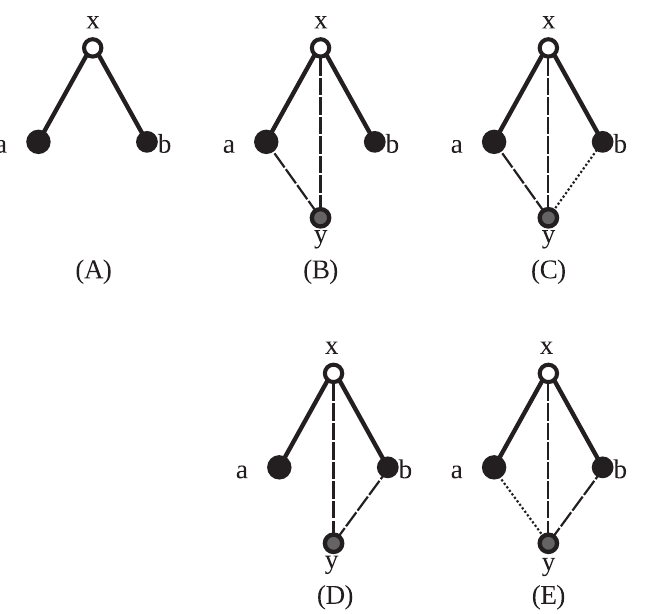
Fig 10. Construction of an equation. (A) G ( x ) ’ Orbit representative 2. (B) G 0 ( x ) = G ( x ) [ {{ y , x }, { y , a }} ’ Orbit representative 11. (C) G 0 ( x ) [ { y , b } ’ Orbit representative 13. (D) G 00 ( x ) = G ( x ) [ {{ y , x }, { y , b }} ’ Orbit representative 11. (E) G 00 ( x ) [ { y , a } = G 0 ( x ) [ { y , b }.